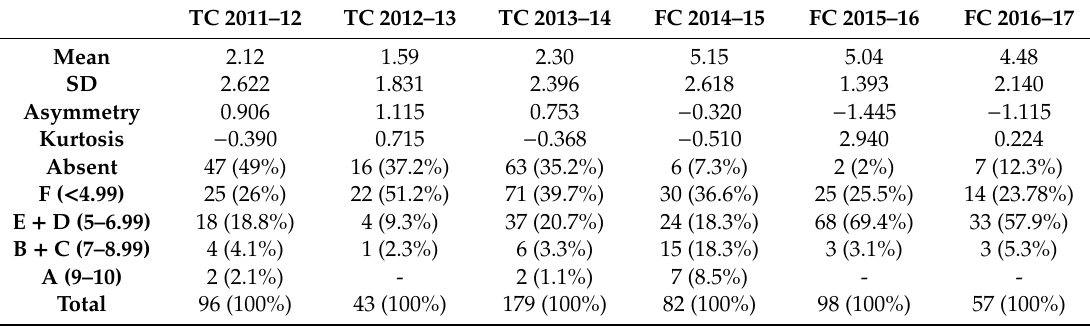
Table 1. Descriptive values of the performance in the regular call according to methodology in